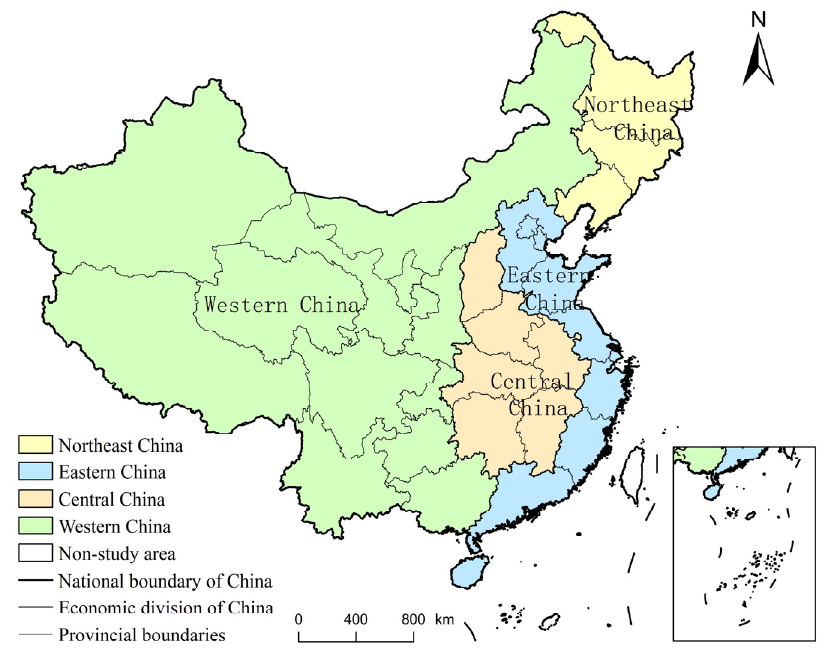
Figure 1. The four economic divisions of China.